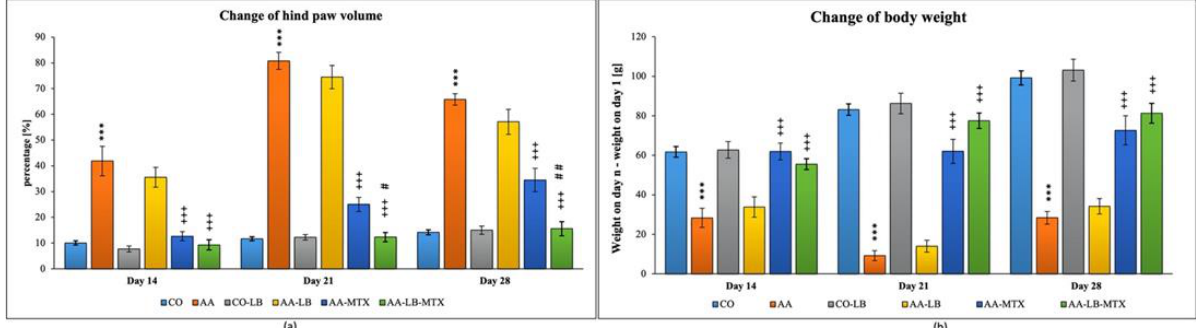
Figure 1. Change of hind paw volume (cHPV) ( a ) and change of body weight (cBW) ( b ) were as- sessed on experimental days 14, 21, and 28 in rats. CO — healthy control group, AA — group of con- trols with adjuvant arthritis (AA), CO-LB — a control group of healthy animals administered with L.